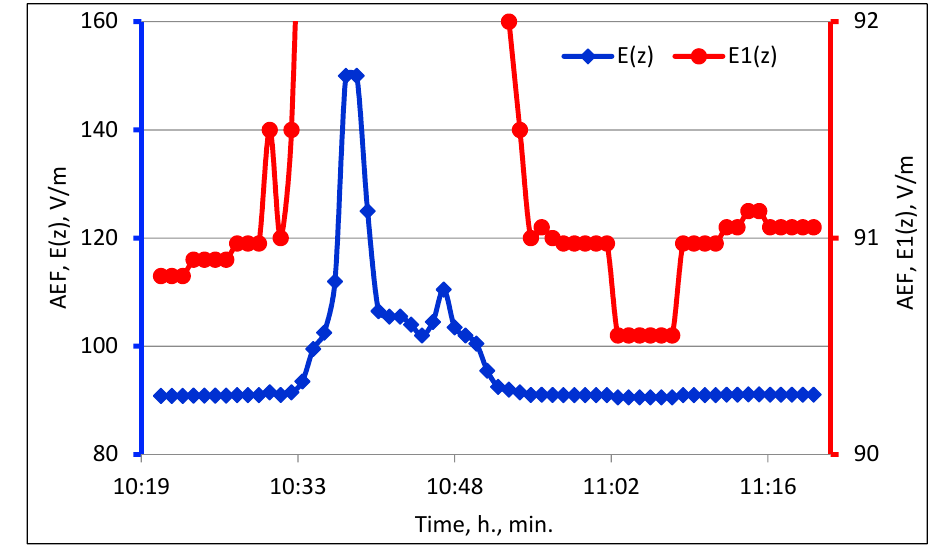
Figure 1. Increase in atmospheric electric field recorded with a stationary fluxmeter on 9 June 2005; the mean background level is 90 V/m; the maximum amplitude is 150 V/m; E(z) and E1(z) records on small and large scales, respectively.